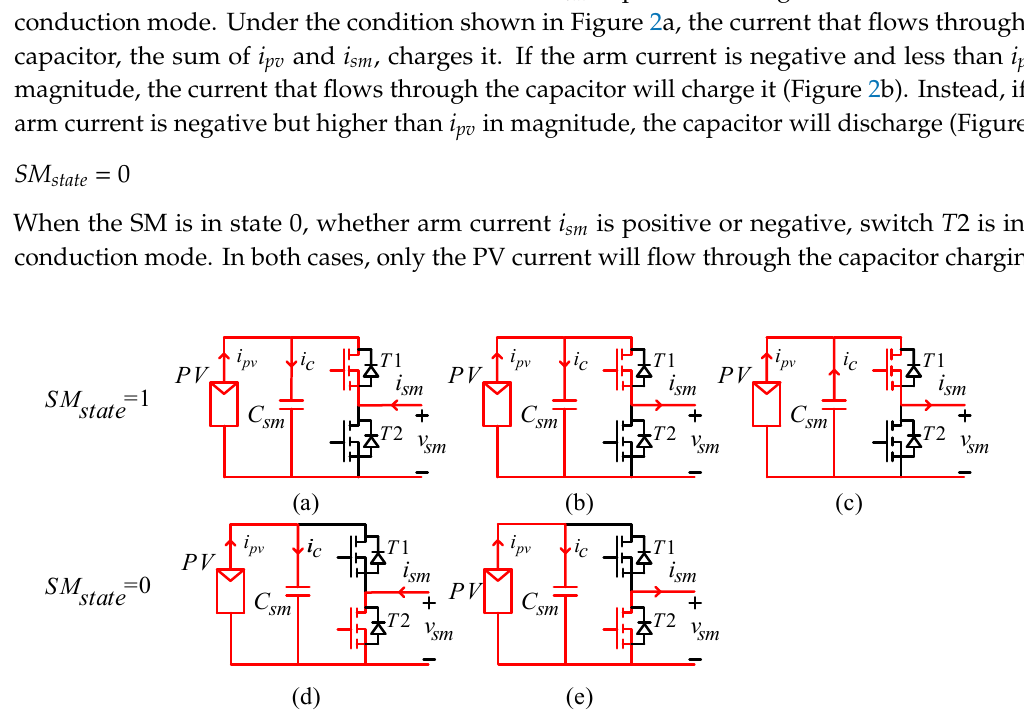
Figure 2. Possible states of submodule depending on direction of arm and PV currents: ( a ) SM in on-state, with positive arm current and charging capacitor; ( b ) SM in on-state, with negative arm current and discharging capacitor; ( c ) SM in off-state, with negative arm current and discharging capacitor; ( d ) SM in off-state, with positive arm current and charging capacitor; ( e ) SM in off-state, with negative arm current and charging capacitor.